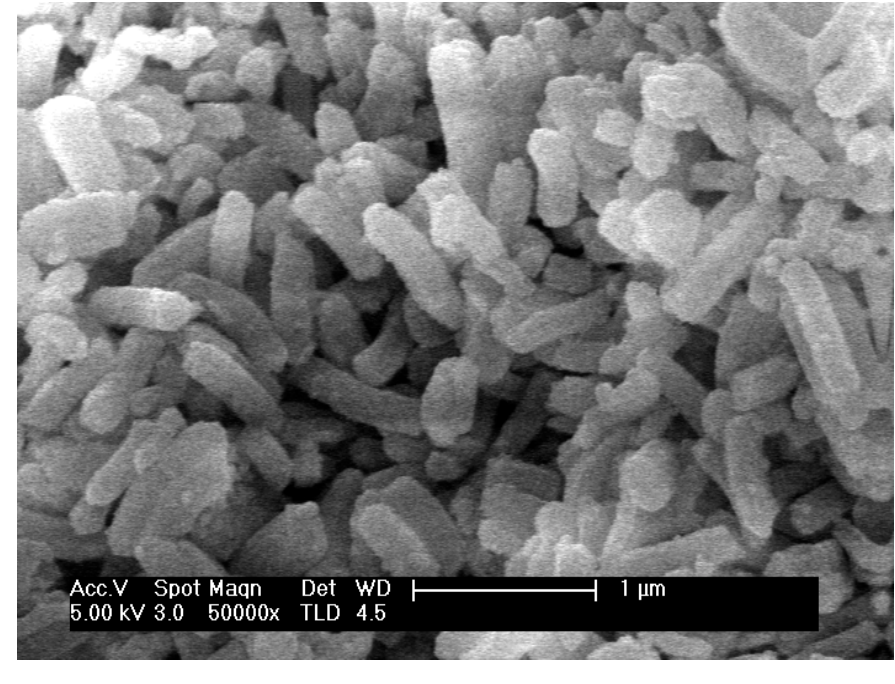
Figure 1. SEM of sample 0.20-E. Table 2. Chemical composition (wt%) and TG results of the supports and the Au-containing catalysts.